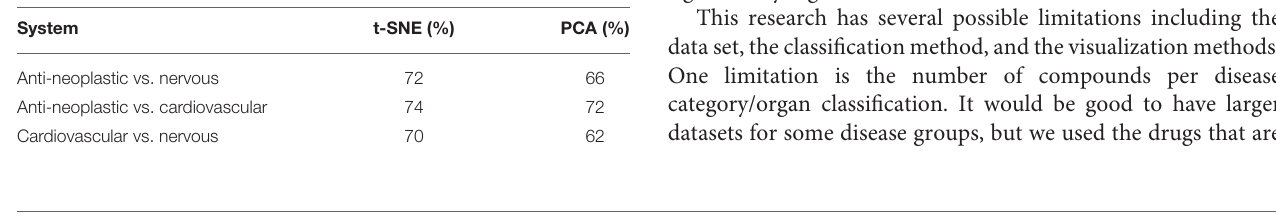
TABLE 5 | Classification results of anti-neoplastic vs. nervous system drugs, where specificity represents the nervous system and sensitivity represents the anti-neoplastic. Training set Test set